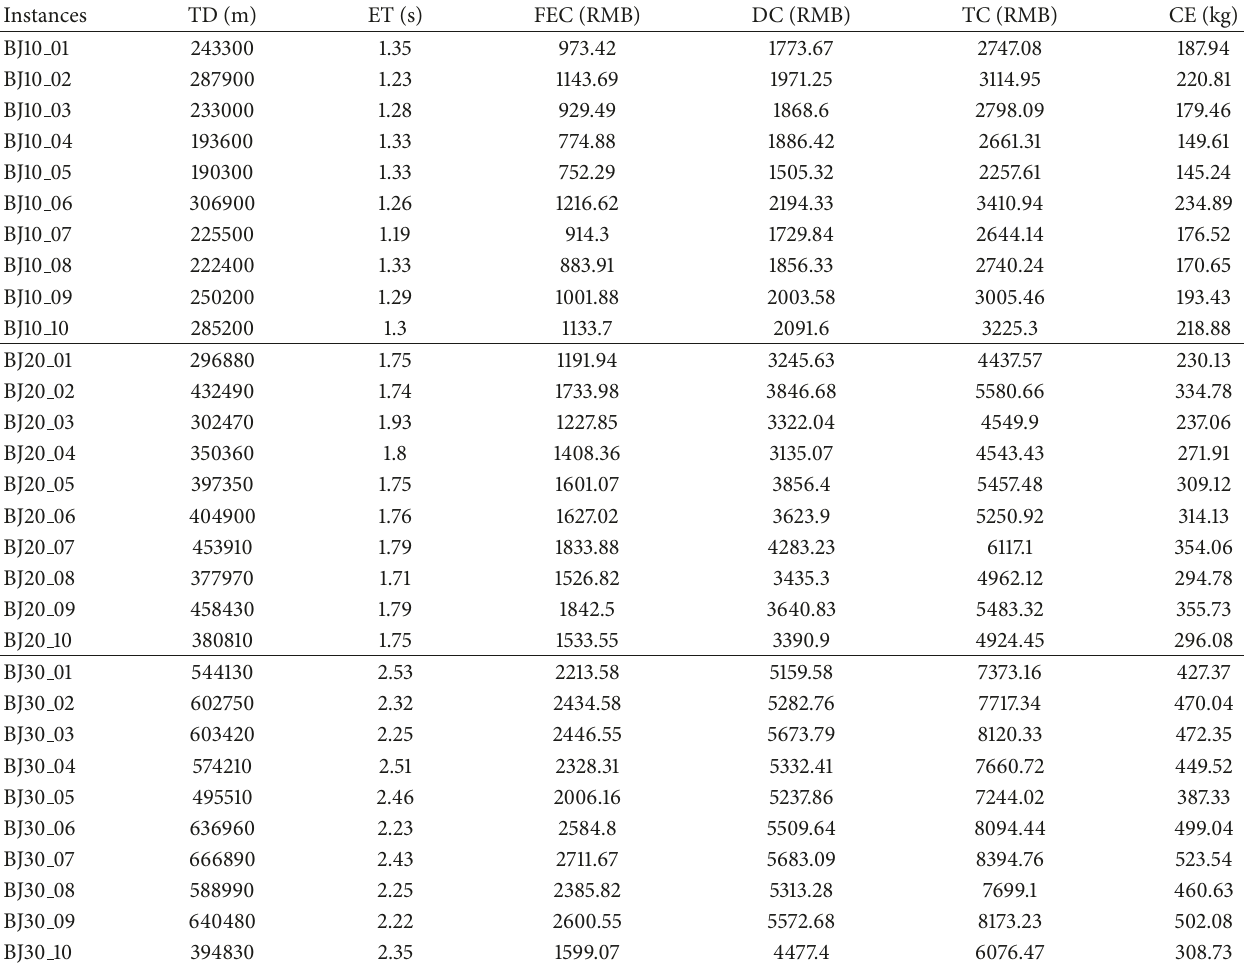
Table 8: Cost components with closed routes.